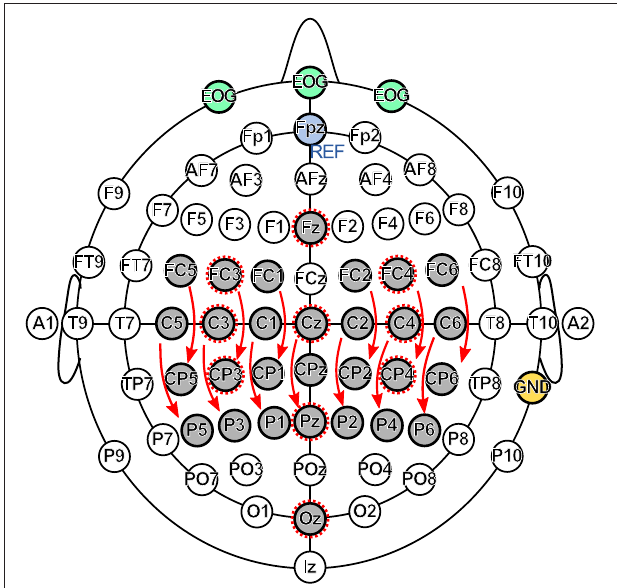
FIGURE 4 | Electrode setup. The EEG was recorded at 29 channels (gray), the EOG at 3 channels (green). The Fpz electrode (blue) was used as reference (REF), the right mastoid (yellow) as ground (GND). The SSSEP channel set consisted of 13 bipolar channels indicated by arrows, the P300 channel set of 10 monopolar channels indicated by dashed